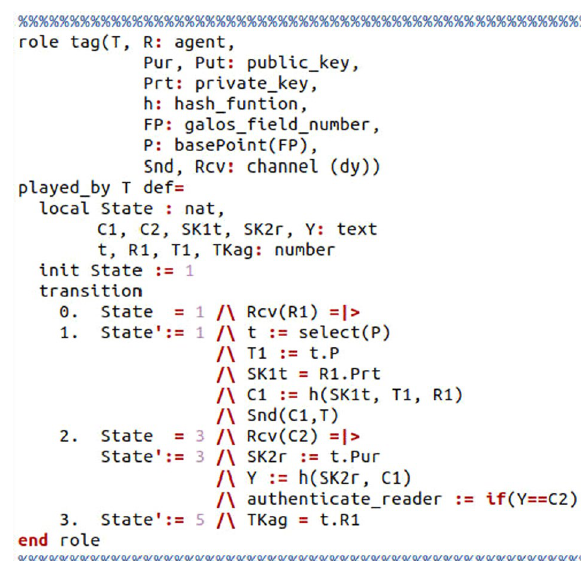
Fig. 6 Authentication steps for the card in HLPSL